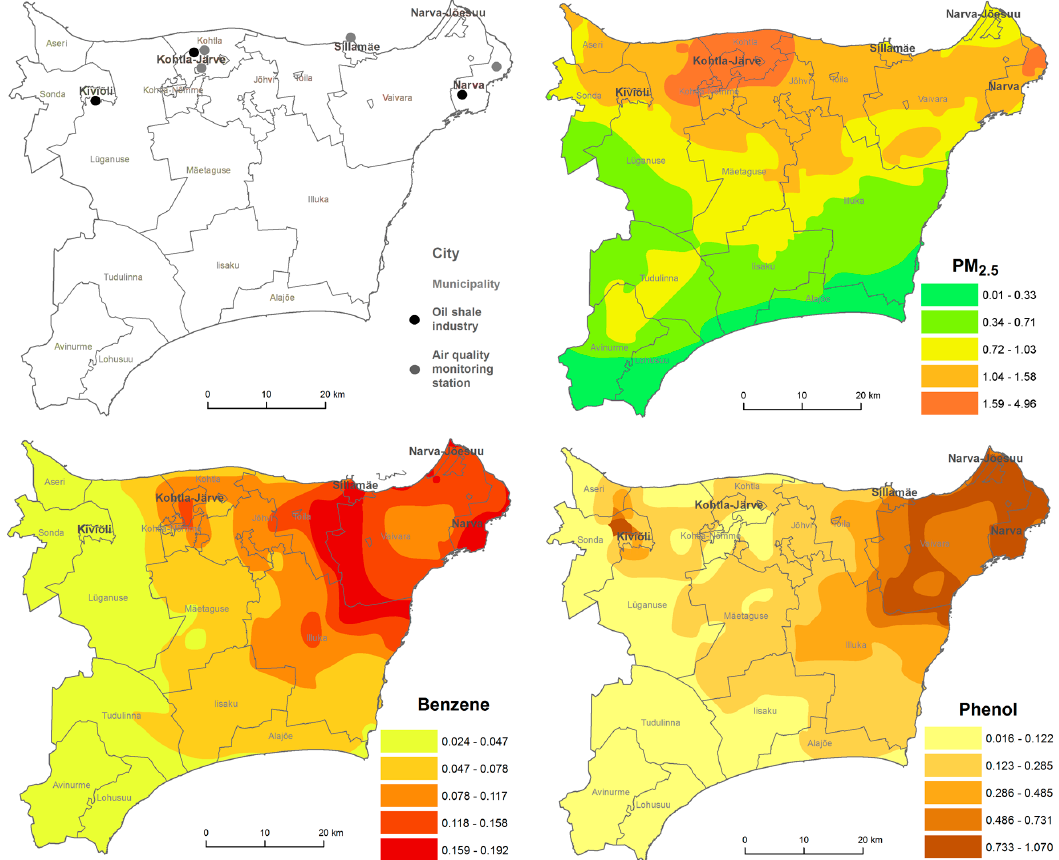
Figure 1. Oil shale industry facilities, air quality monitoring stations and annual average concentrations ( μ g/m 3 ) of fine particles (PM 2.5 ), benzene, and phenol in the ambient air of Ida-Viru County.